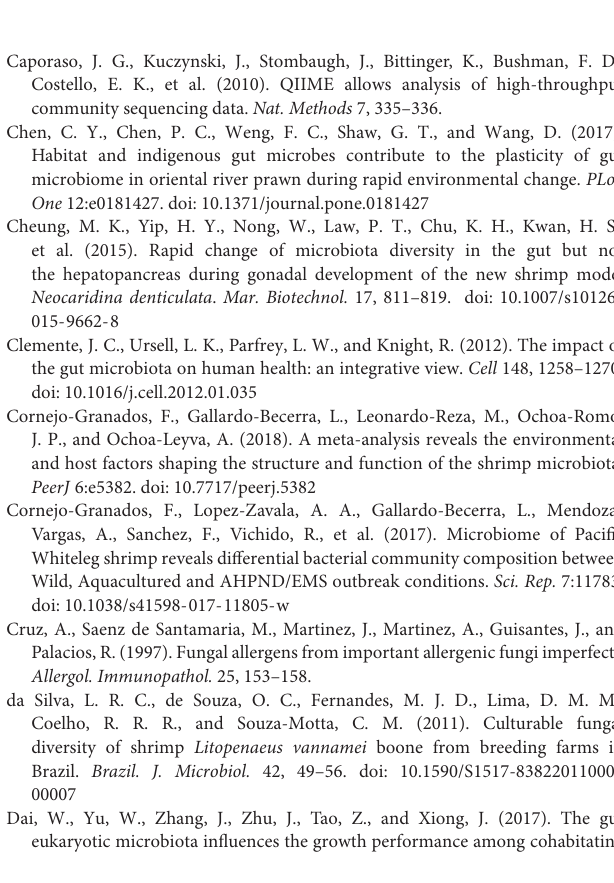
FIGURE S1 | Operational taxonomic units (OTU) number of each group. FIGURE S2 | Rarefaction curves. (A) OTU number rarefaction curves for summer samples; (B) OTU number rarefaction curves for winter samples; (C) Shannon index rarefaction curves for summer samples; (D) Shannon index rarefaction curves for winter samples. FIGURE S3 | Species relative abundance curve. Red boxplots depict the sum of species; green boxplots depict the emerging probability of share species. TABLE S1 | The sequencing data for each sample. TABLE S2 | All the obtain OTUs and taxonomy. TABLE S3 | (A) Differences in alpha diversity between intestine and hepatopancreas. (B) Differences in alpha diversity between summer and